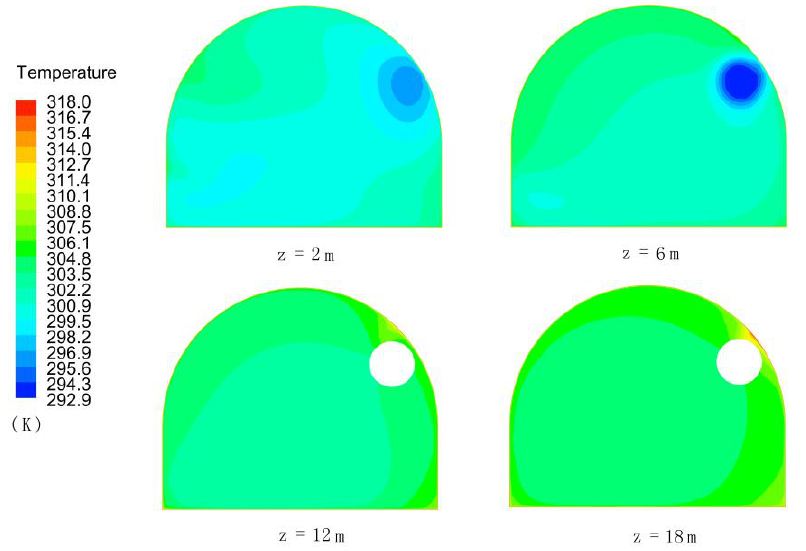
Figure 3. Model 1 section temperature